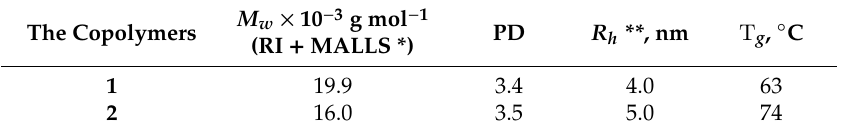
Table 1. Physicochemical characteristics of the N-vinylpyrrolidone-triethylene glycol dimethacrylate (VP-TEGDM) copolymers. The Copolymers